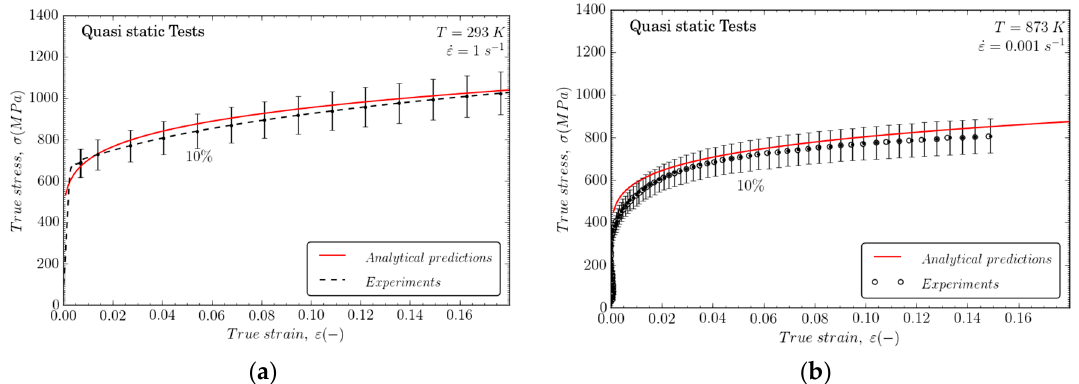
Figure 8. ( a ) Comparison between analytical predictions of the Johnson–Cook model and experiments at T 0 = 293 K and (cid:2013)̅(cid:4662) (cid:2868) = 1 s (cid:2879)(cid:2869) ; ( b ) Analytical predictions of the constitutive model within wide ranges of strains and strain rates at T 0 = 873 K.